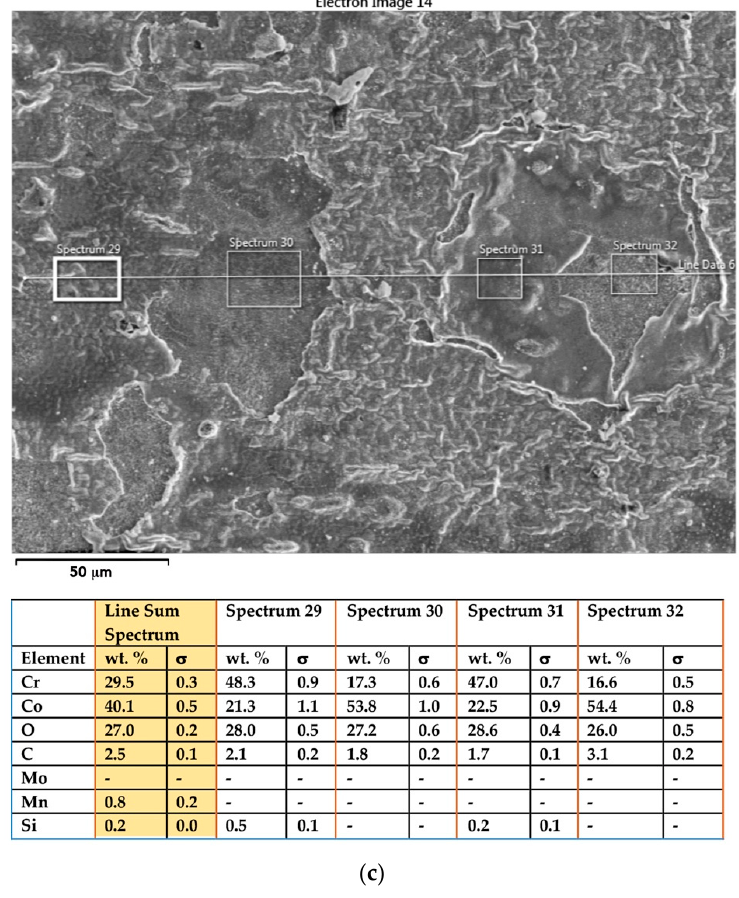
Figure 4. SEM–EDS results for casted MC-HT: ( a ) SEM-SE micrograph with corresponding EDS line on the right; ( b ) the surface distribution of O, Co, Cr, Mo, C; ( c ) EDS results from marked micro-areas.